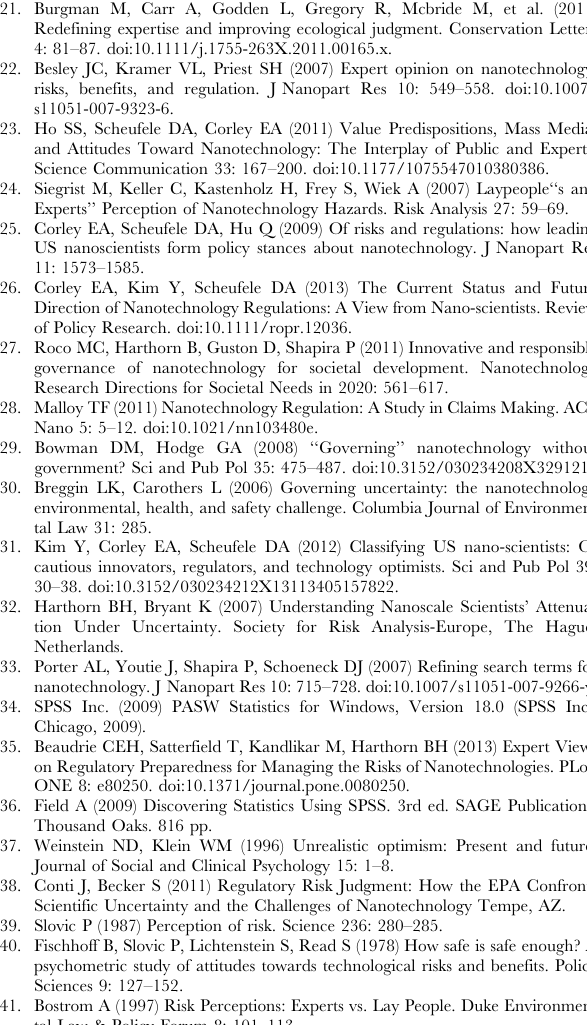
Table S2 Games-Howell post hoc analysis indicating significant differences in means between NSE-NEHS, NSE-NREG, and NEHS-NREG group